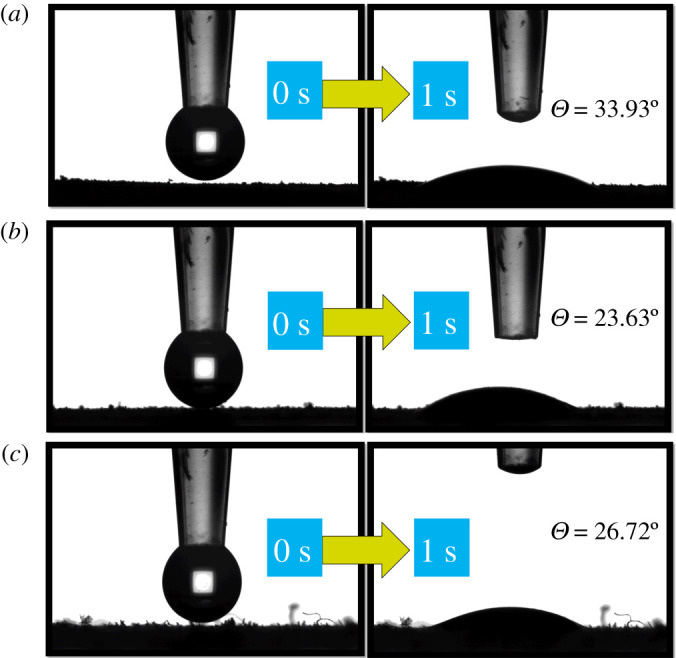
Contact angle diagrams of GO (a), CNCs (b) and CNCs-GO (c).